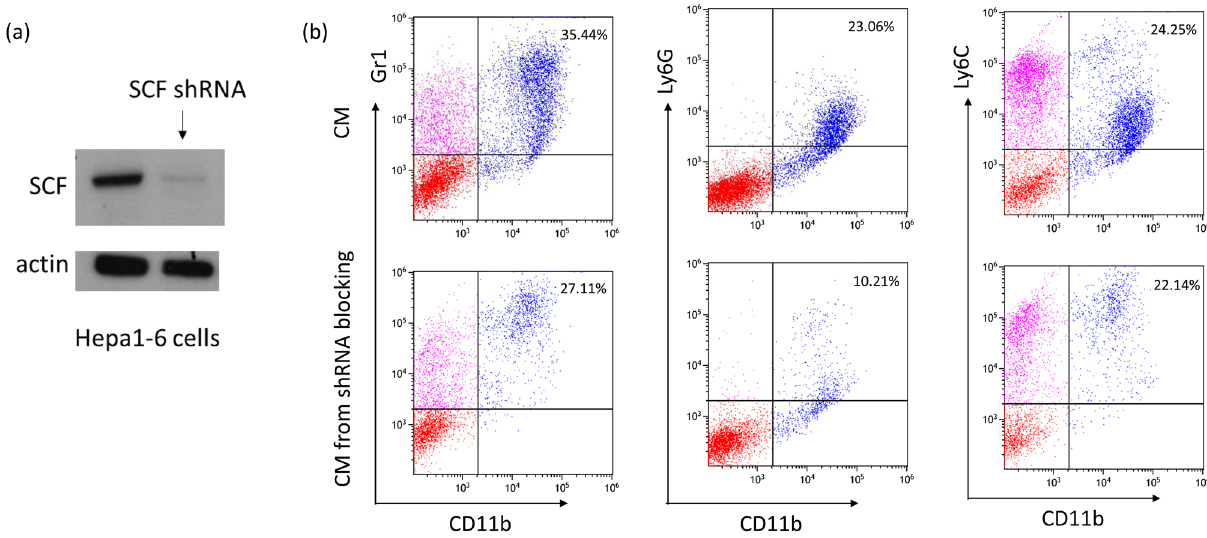
Figure 6. Representative Hepa 1–6 transfection with shRNA of SCF. ( a ) The expression of SCF was effectively blocked by pENTR/H1/TO shRNA of SCF. ( b ) The frequency of MDSCs decreased when the spleen cells were cultured in the conditional medium collected from Hepa1-6 cells blocked by pENTR/H1/TO